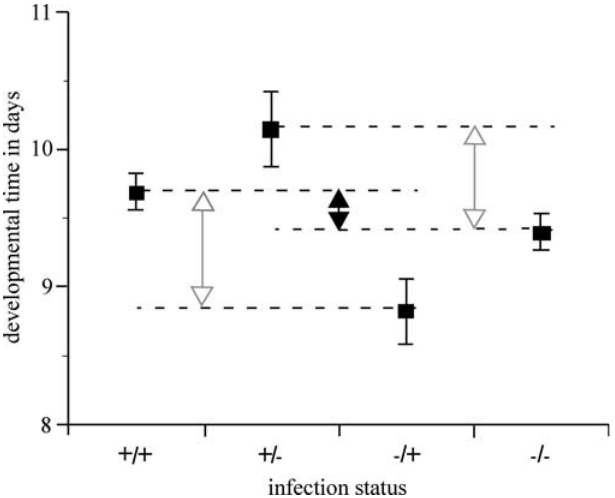
Figure 1. Developmental Time in Days and 95% Confidence Intervals for the Four Categories of Infection Status In the infection status category denominations (e.g., þ / þ , þ / (cid:1) , (cid:1) / þ , and (cid:1) / (cid:1) ), the first symbol indicates the infection status of the focal individual, and the second indicates that of its competitor. The filled black arrow represents the commonly measured direct costs of parasitism, and the open grey arrows represent the indirect costs through the modification of intraspecific competitiveness by parasitism (see text). DOI: